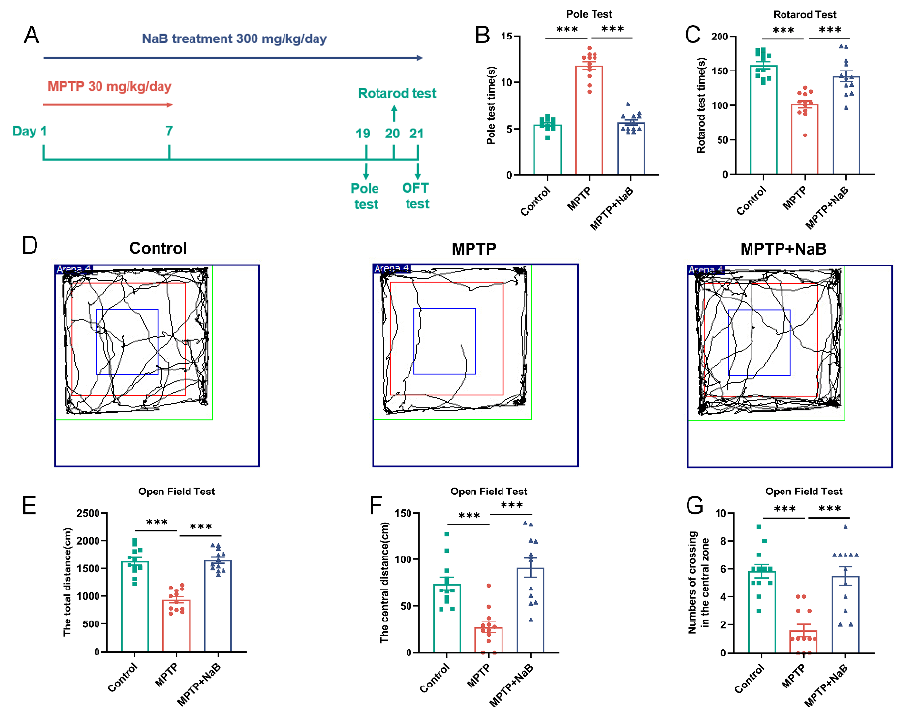
Figure 1. Sodium butyrate (NaB) improves motor functions and exploratory behaviors in mice with 1-methyl-4-phenyl-1,2,3,6-tetrahydropyridine (MPTP)-induced Parkinson’s disease (PD). ( A ) A diagrammatic representation of the treatment given to animals. ( B ) Pole test. ( C ) Rotarod test. ( D ) Representative images from open field test (OFT) movement trials. The ( E ) total distance, ( F ) central distance, ( G ) number of crossings in the central zone of the OFT. n = 12 mice per group; *** p < 0.001; data are expressed as means ± SEM.